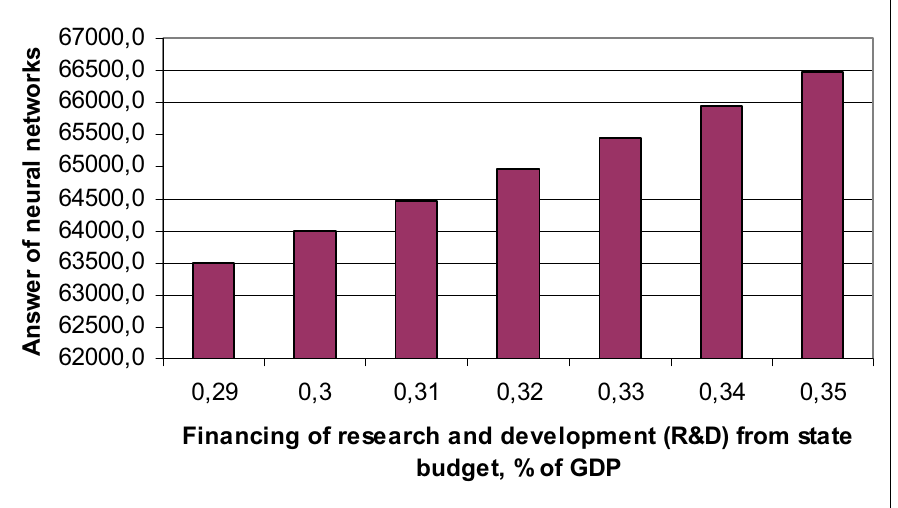
Fig. 5. The influence of the research and development financing from the national budget over